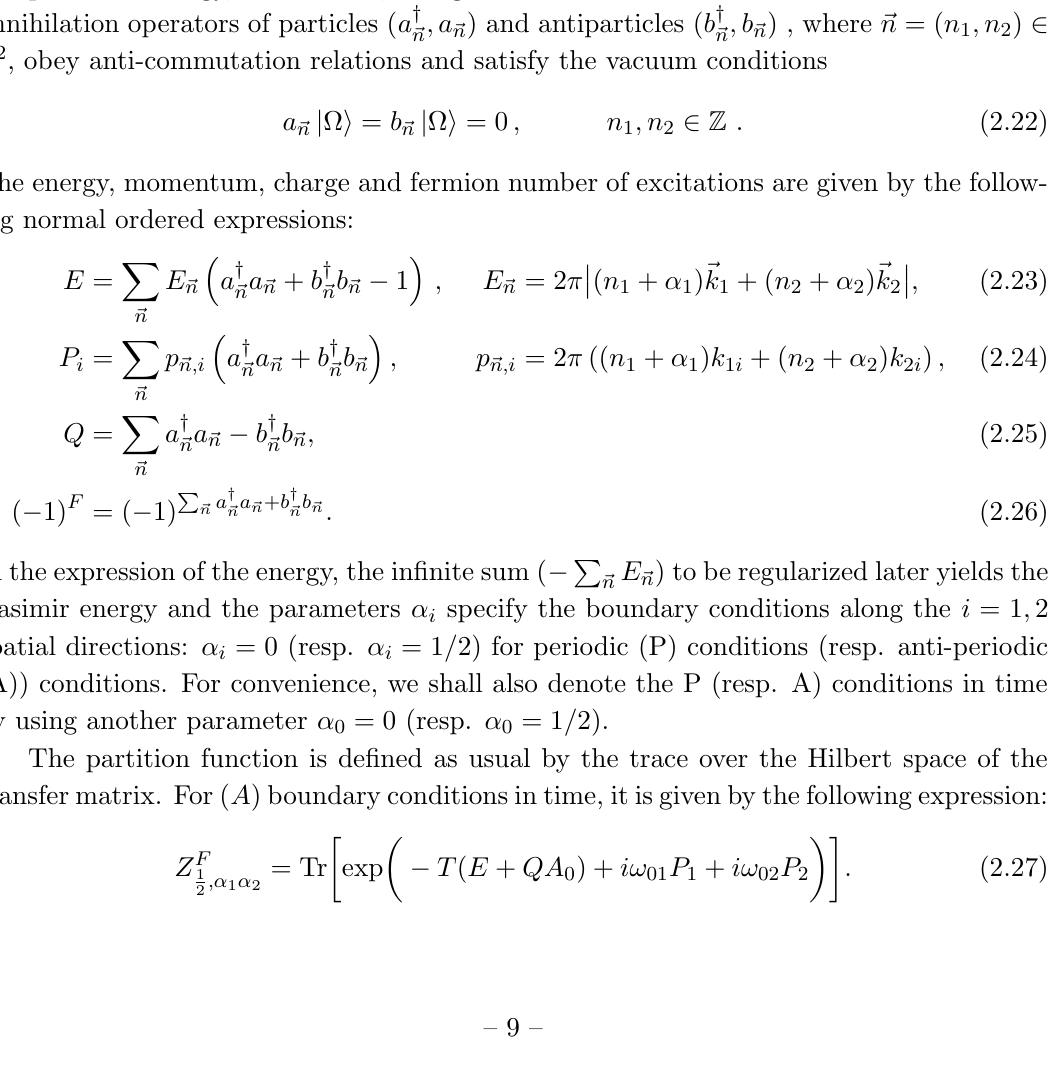
Figure 2 . Three-dimensional Corbino donut. The addition of (cid:13)uxes (cid:8) quantization of k x and k y momenta,